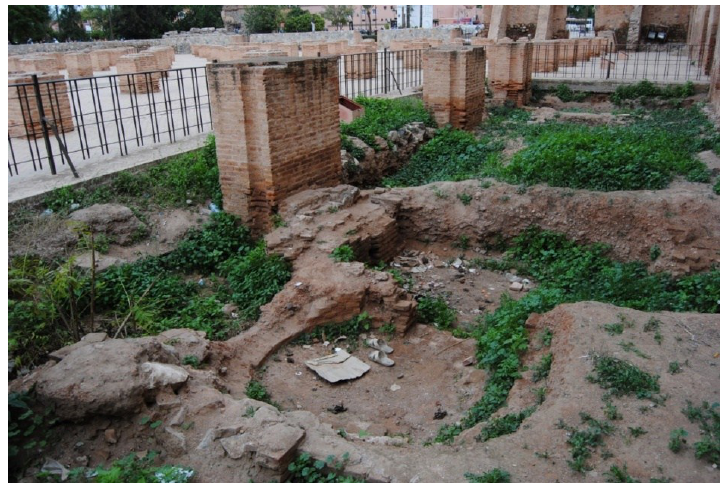
Figure 6. Remains of the mechanical system of the maq ṣ ūra corresponding to the first Kutubiyya (Marrakech). Photo took by author.